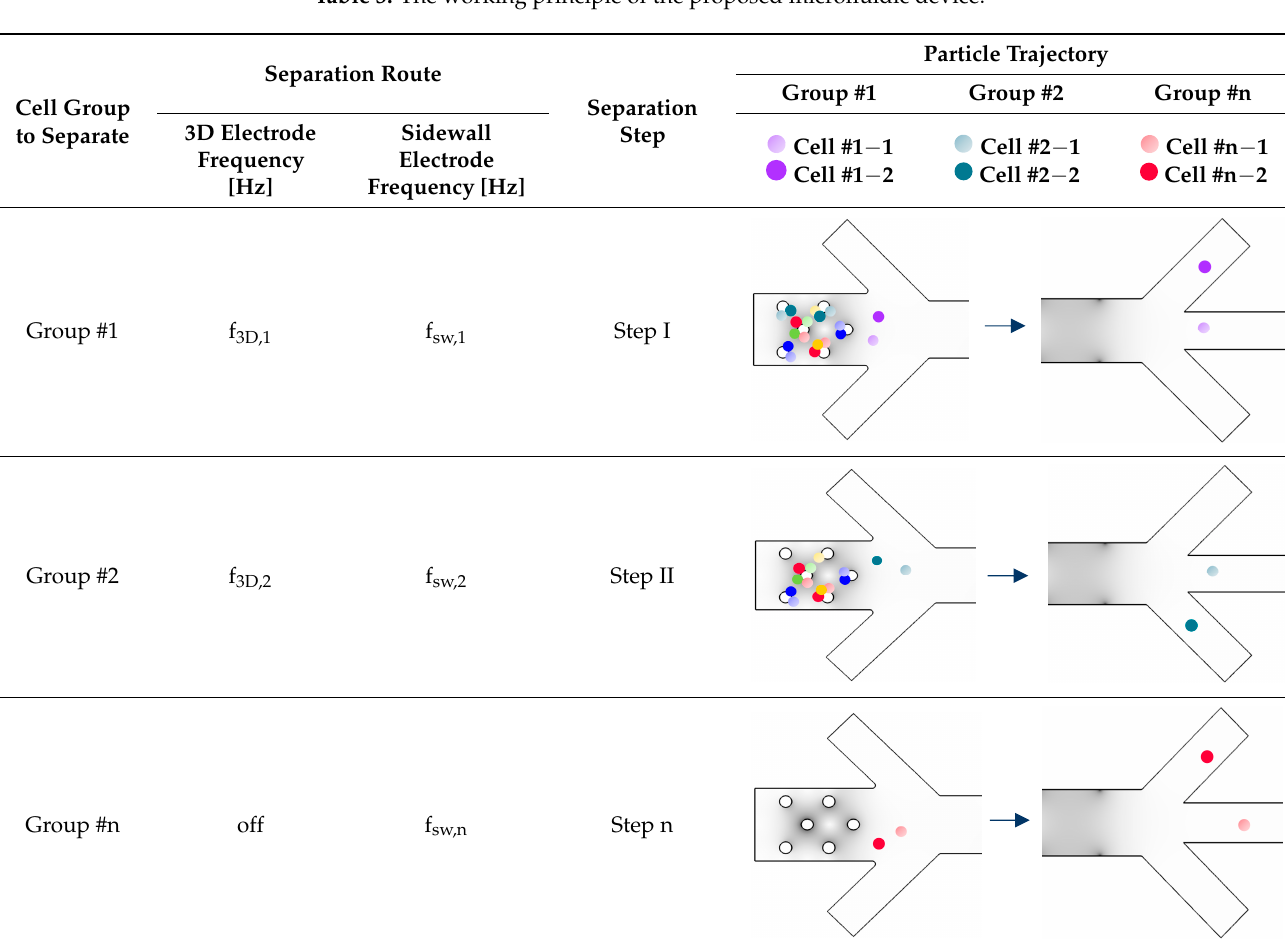
Figure 2. The real part of Clausius − Mosso tt i (CM) factor for cells of group 1 to n. Group number two has the cells whose crossover frequencies are right after Group one cells (Figure 2). This procedure continues until the last two cell types. The cells enter the separation device from the particle inlet (Figure 1a) and move to Section I. The frequency of the 3D electrodes is set to f 3D,1 (Figure 2), at which all the cells